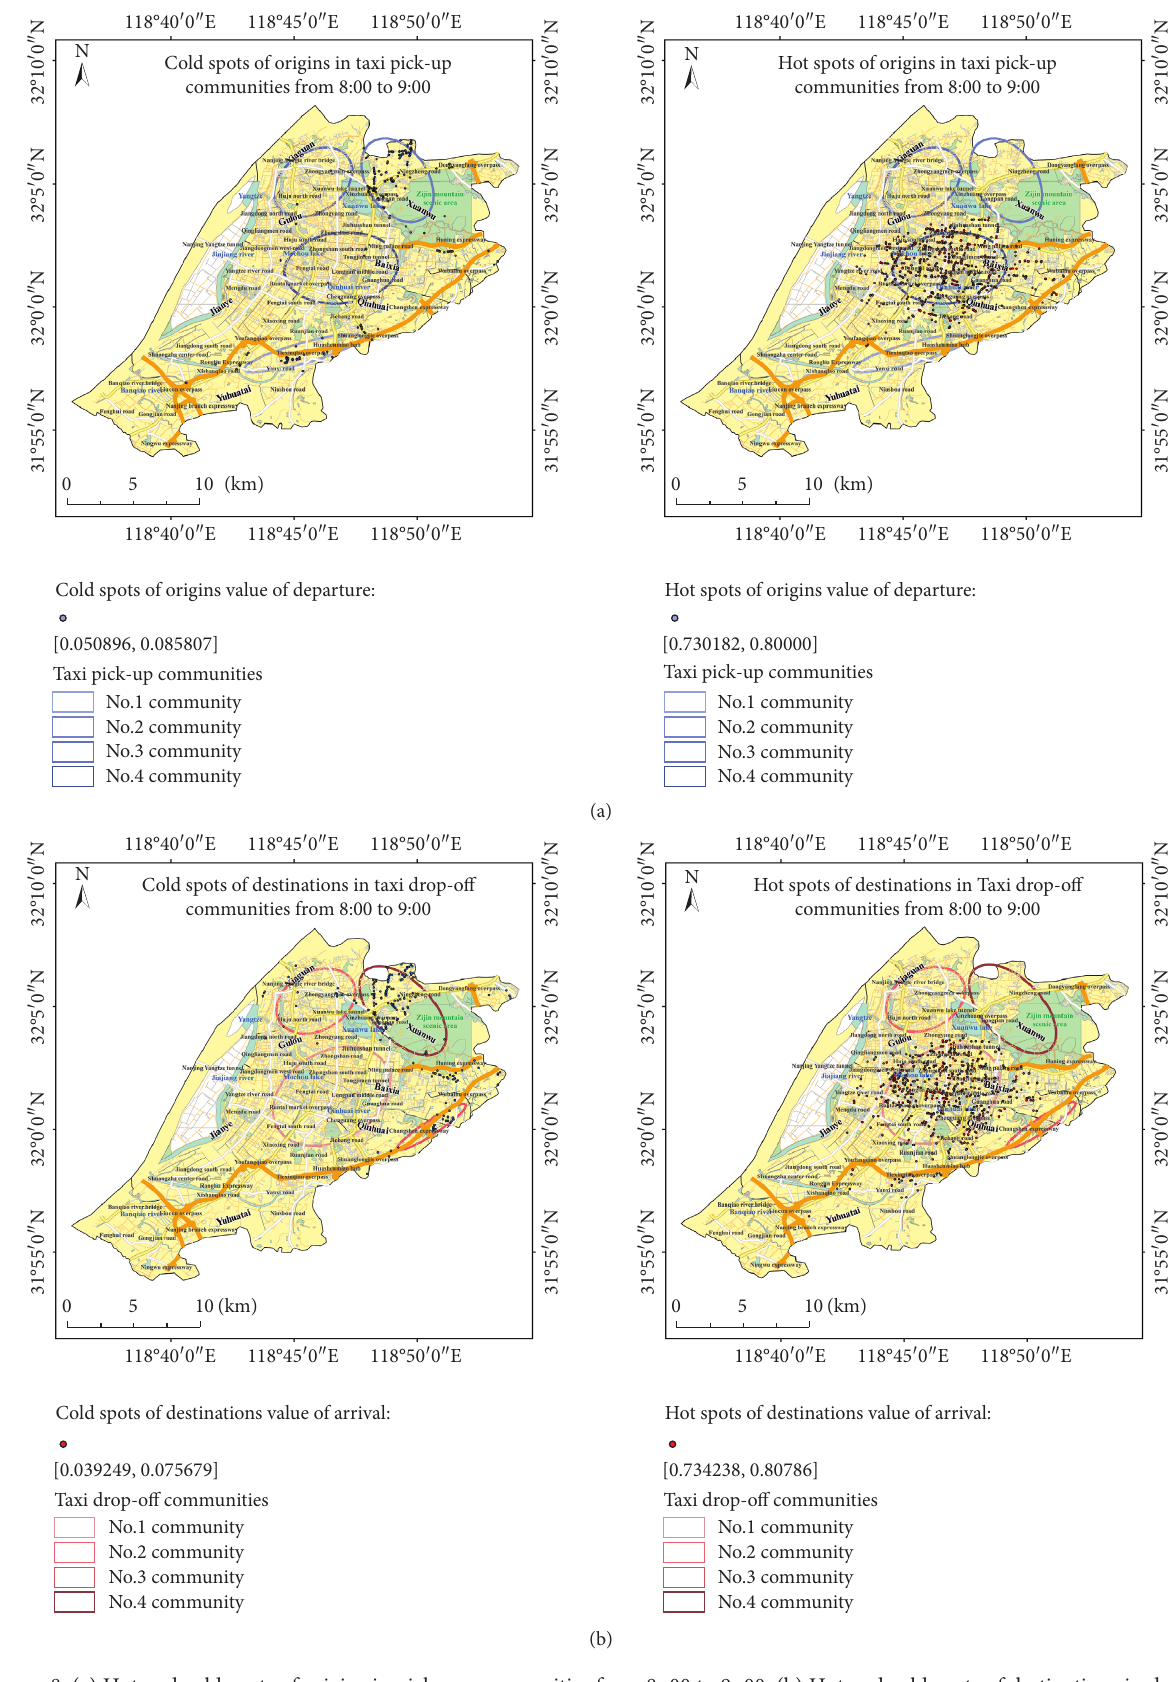
Figure 8: (a) Hot and cold spots of origins in pick-up communities from 8:00 to 9 :00. (b) Hot and cold spots of destinations in drop-off communities from 8 :00 to 9: